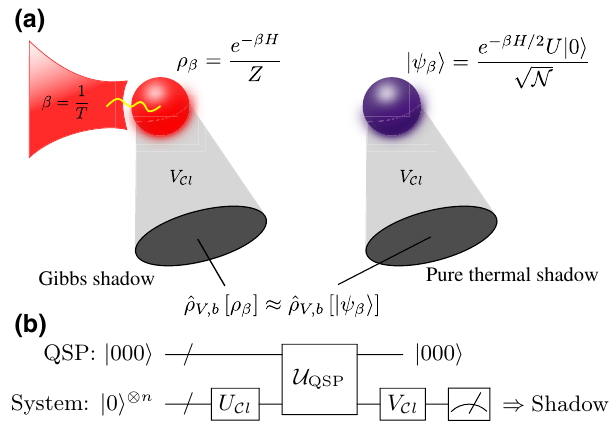
FIG. 1. (a) The classical shadows of a Gibbs state ρ β , here rep- resented as a quantum system (red sphere) in thermal equilibrium with its environment (red bath), are equal to the classical shad- ows constructed from a thermal pure quantum state | ψ β (cid:2) (purple sphere). The random measurement direction of the shadows is determined by the Clifford unitary V C l . (b) A circuit diagram of the quantum circuit that implements a pure thermal shadow with quantum signal processing